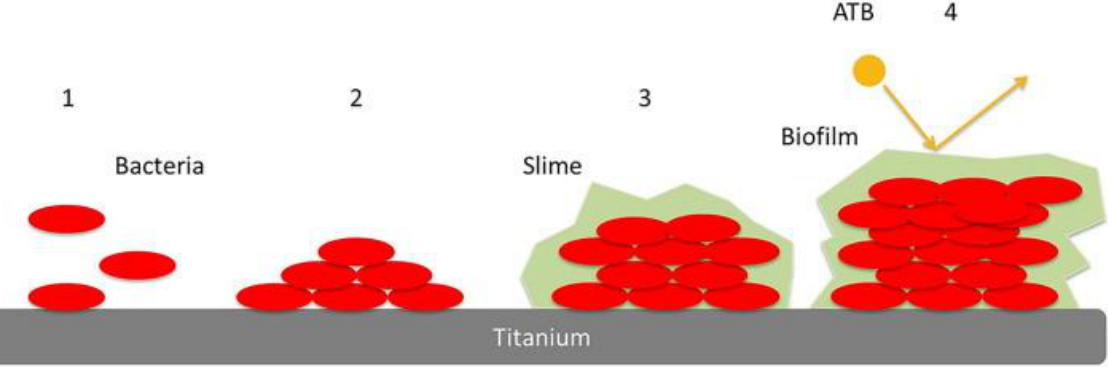
Figure 1. Diagrammatic sketch of the biofilm formation process on the titanium surface. 1. Bacterial adhesion. 2. Formation of microcolonies. 3. Maturation of the biofilm. 4. Biofilms produce an exopolysaccharidic matrix that protect them from the host immune response and antibiotics. Reprinted with permission from [24] 2019 Acta Materialia Table 1. Mechanisms of biofilm-based antibiotic resistance and tolerance in pathogenic bacteria. Mechanisms Examples